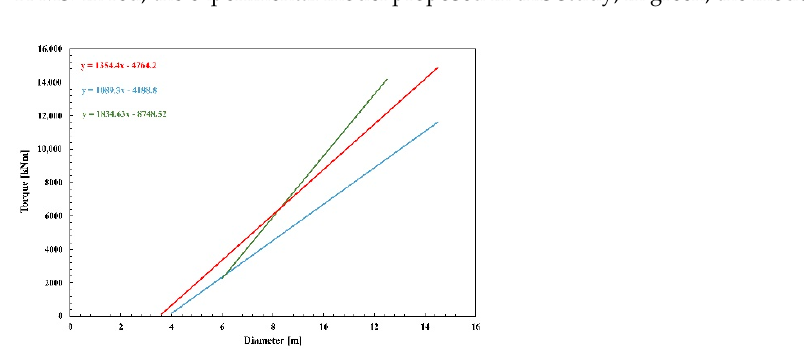
Figure 21. Trend of the torque vs. the diameter based on data collected from the analysis of open TBMs. In red, the experimental model proposed in this study; in blue, the model proposed by [42]; and in green, the model proposed by [43].